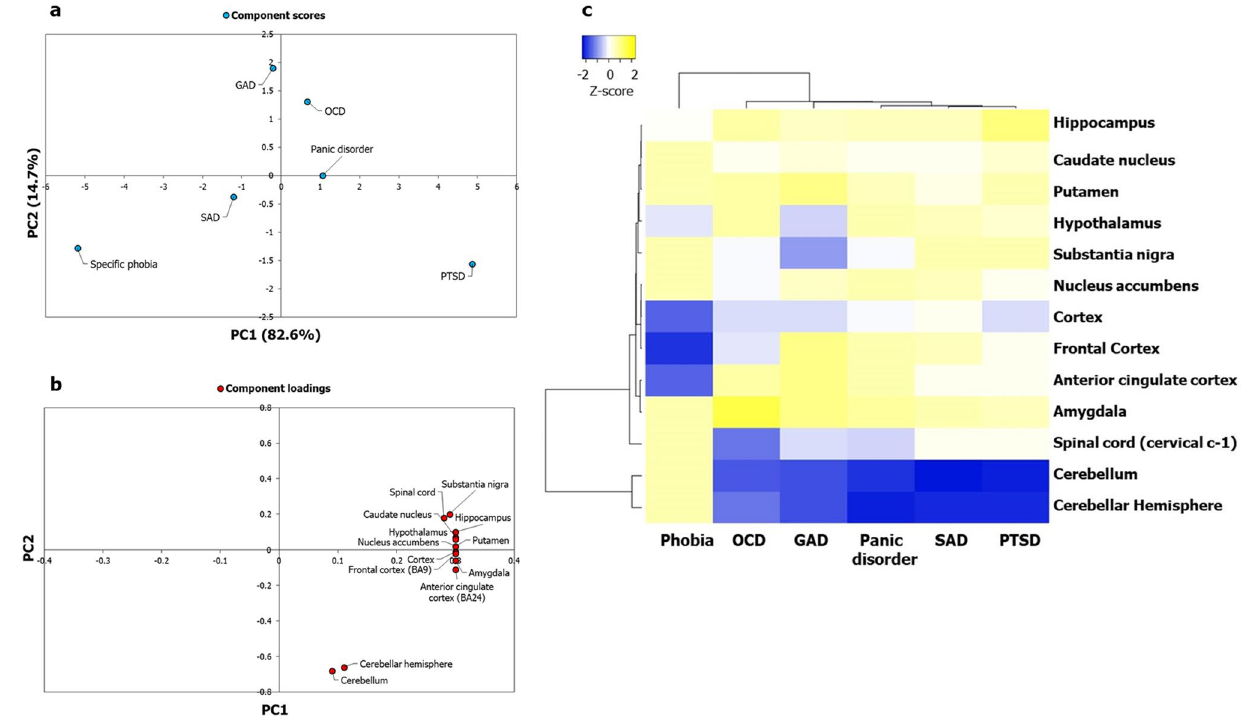
Figure 2. Principal component analysis and clustering analyses of the ADIs based on enrichment patterns in the brain failed to capture putative regional specificities and clusters of the ADs. ( a ) PCA was performed with the p values of enrichment of the ADI genes in 13 brain regions compiled from GTEx. p values were transformed to − log 10 P values and a data matrix with brain regions (rows) and ADs (columns) (represented as a heatmap in ( c )) was constructed out of these log-transformed values. Unit variance scaling was applied across this matrix. SVD with imputation was used to extract the principal components (PCs). Component scores (n = 6) corresponding to PC1 and PC2 explaining 82.6% and 14.7% of the total variance were plotted along X and Y axes respectively. ( b ) Component loadings of 13 dimensions, i.e. brain regions, contributing to PC1 and PC2 shown in ( a ) were plotted along X and Y axes respectively. Relatively equal and moderate contribution of all the brain regions, except the cerebellum and the cerebellar hemisphere, shows that ~ 97% of the variance captured by PC1 and PC2 plotted in ( a ) may not have reflected regional specificities of the ADs. ( c ) Variations in region-wise enrichment of ADI genes (computed based on GTEx data) are represented in the form of a heatmap. p values indicating statistical significance of enrichment were converted into − log 10 P values. Each cell in the heatmap depicts a normalized z-score derived from a − log 10 P value corresponding to a brain region. Z-scores indicate relative enrichment of specific brain regions in an ADI and are computed based on the number of standard deviations that separate a given p value from the mean. Clustering was performed using the hierarchical clustering method with average linkage. The dendrograms were derived from the clustering analysis based on computation of Pearson correlation coefficients between the data points. The region-wise enrichment profile of specific phobia seems to be distinct from that of OCD, GAD, panic disorder, SAD and PTSD, which were all identified to be closely related. Clusters among the latter five disorders were not distinctive. The clustered heatmap was created using Heatmapper (http:// www. heatm apper.